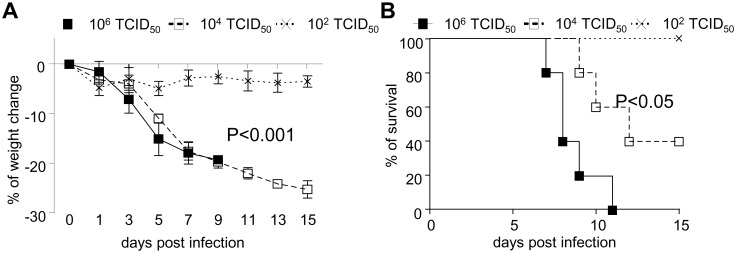
Induction of severe H7N9 infection in humanized mice.Humanized mice were infected with H7N9 virus i.n. at different dose (106, 104, 102 TCID50) in 25μl of saline solution on day 0. The weight change (A) and survival (B) in virus-infected mice (5 mice per group) were monitored and recorded till day 15 post infection.